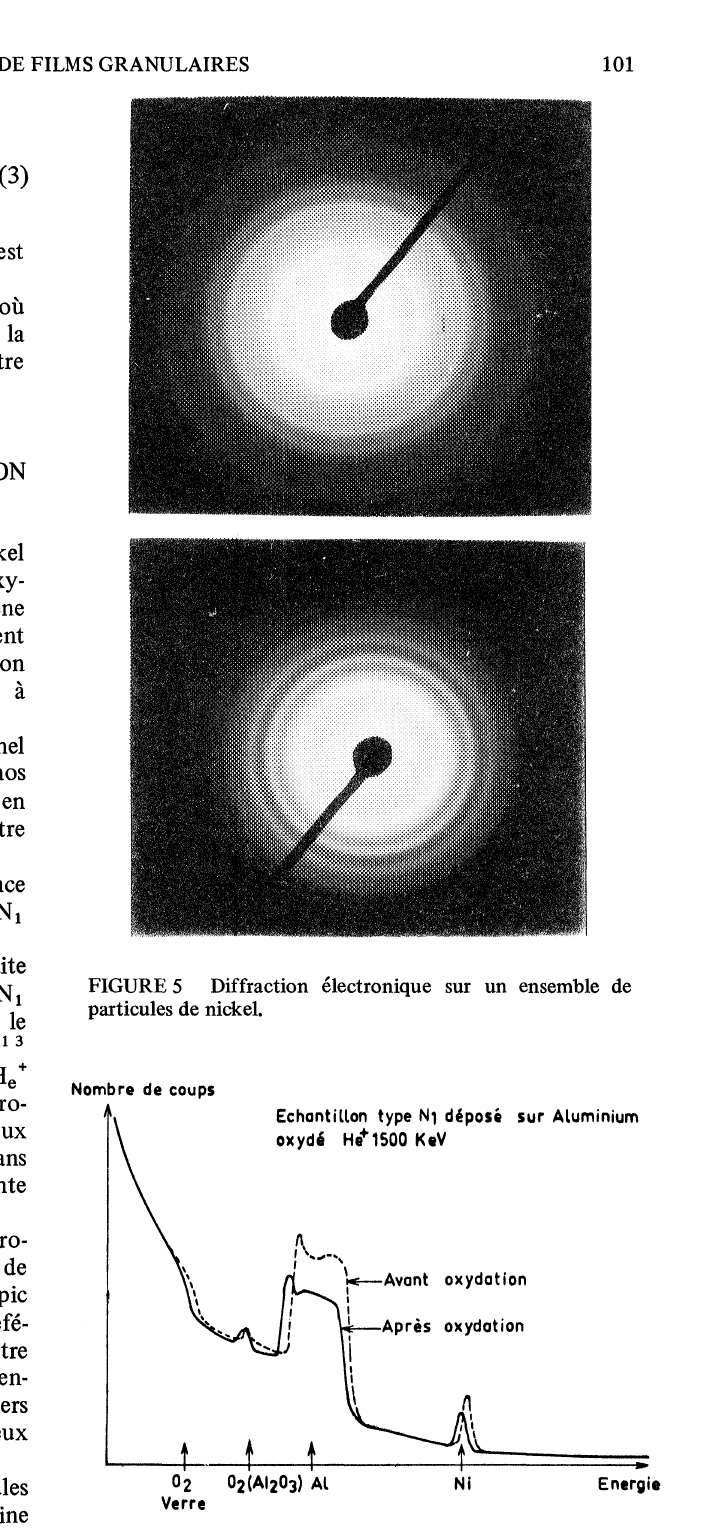
Analyse par rtrodiffusion d’ions